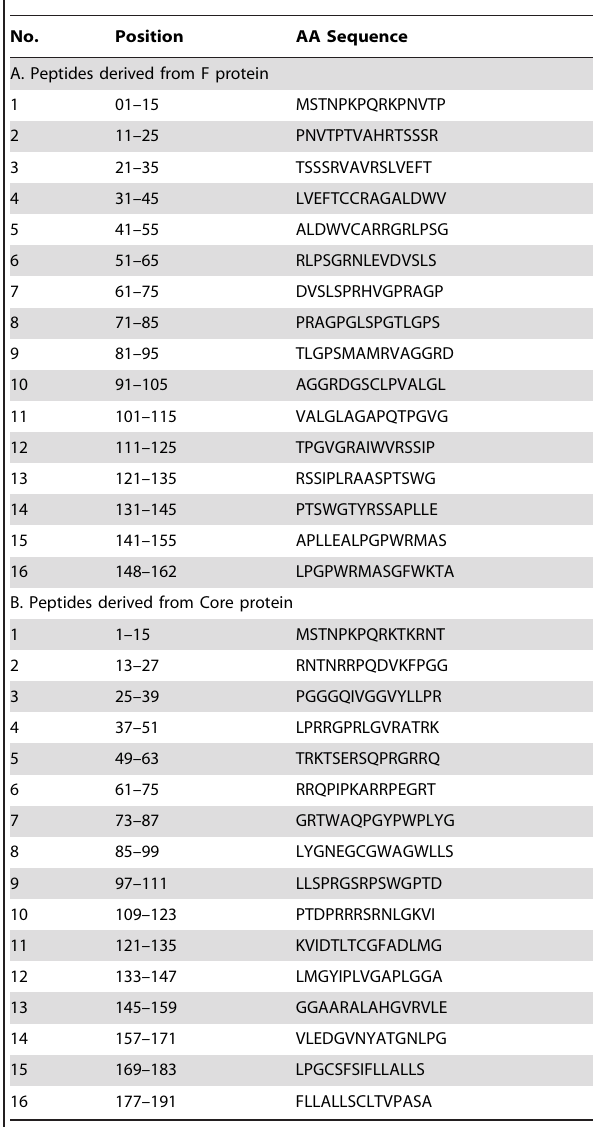
Table 1. Peptide sequences from core and F